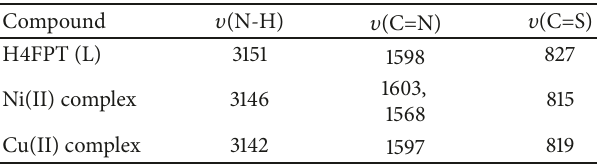
Table 4: IR spectral data of H4FPT and